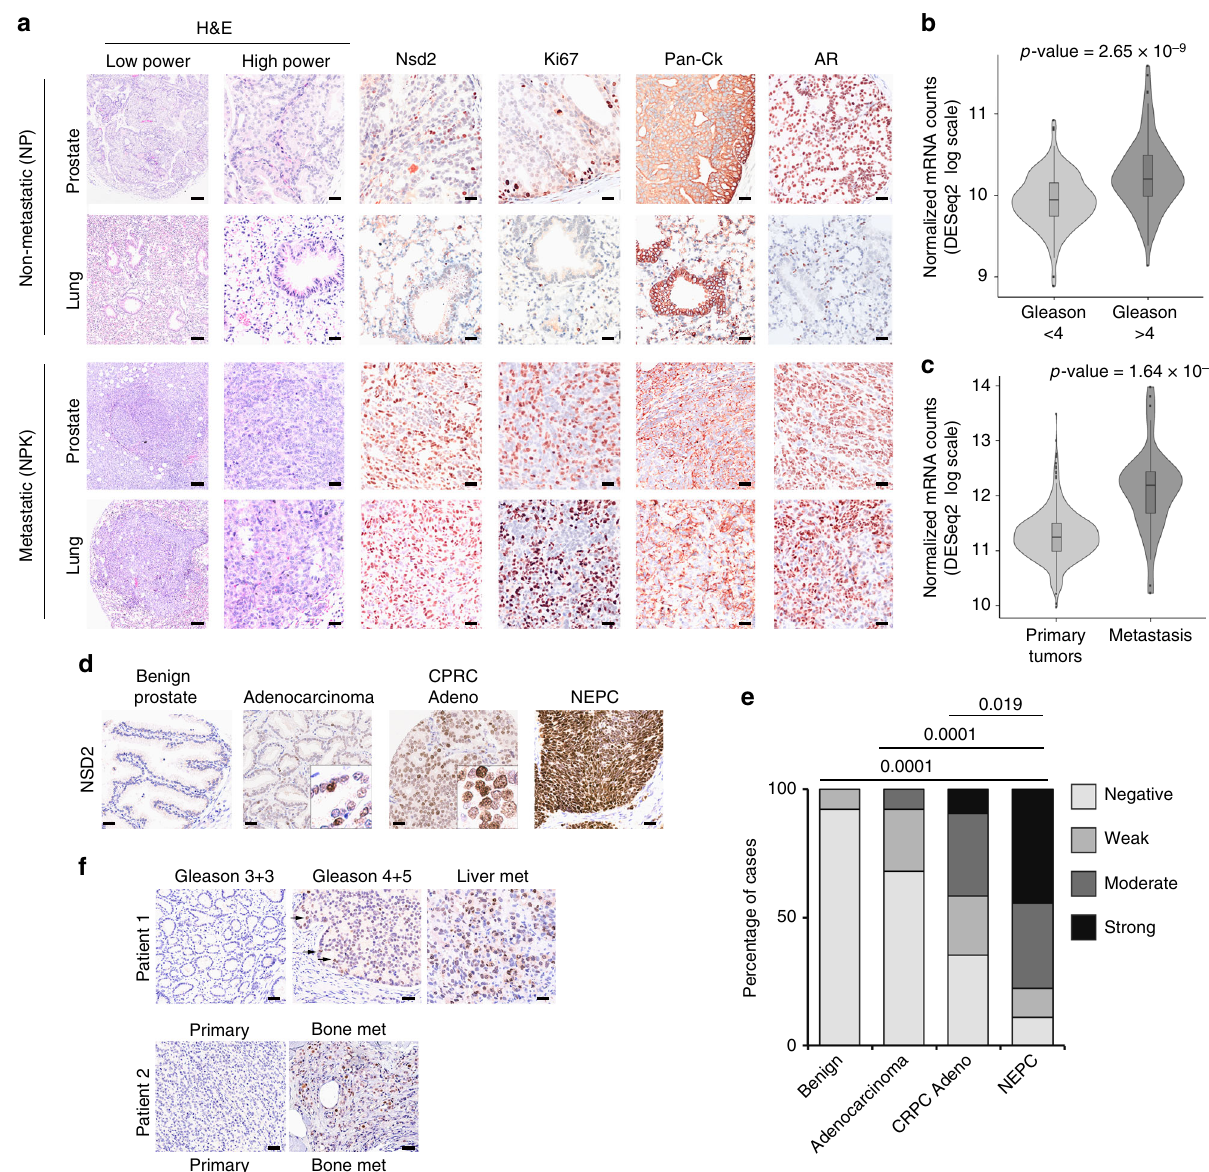
Fig. 4 Expression of NSD2 in prostate cancer and metastases. a Immunostaining of Nsd2 and other markers on mouse primary tumors and metastases. Shown are representative H&E images and immunostaining for the indicated antibodies from non-metastatic NP mice and metastatic NPK mice ( n = 4/ group). Scale bars in the low power H&E images represent 100 microns, and all other panels 50 microns. b , c Violin plots comparing mRNA expression levels of NSD2 in TCGA and SU2C human prostate cancer cohorts (Supplementary Table 1). b compares primary tumors from TCGA divided based on pathological grade [Gleason <4 ( n = 104) or ≥ 4 ( n = 173)], as indicated. c compares primary tumors and metastases from a cohort combining primary tumors from TCGA (all Gleason scores; n = 333) and metastases from SU2C ( n = 51). P -values were estimated using the two-sample two-tailed Welch t - test. d , e Immunostaining of NSD2 on a human prostate tissue microarray (TMA) ( n = 100 independent cases). d shows representative images representing benign prostate, untreated localized adenocarcinoma, castration-resistant adenocarcinoma (CRPC-Adeno) and neuroendocrine prostate cancer (NEPC). Nuclear staining intensity was evaluated blinded by a pathologist and scored as negative (or present in <5% of nuclei), weak, moderate or strong. Scale bars represent 50 microns. e shows quanti fi cation of nuclear intensity staining for each score (negative, weak, moderate, and strong). The p - values compare negative/weak staining versus moderate/strong staining in each group and were calculated using a two-tailed Fisher's exact test. f Immunostaining of NSD2 on matched patient sets of primary prostate cancer and distant metastasis to soft tissues or bone, as indicated. Patient 1 shows representative images of lower pathological grade (Gleason 3 + 3), which is negative for NSD2, and higher pathological grade (Gleason 4 + 5) and a liver metastasis that have increasing expression of NSD2. Patient 2 shows a high grade primary tumor (primary) that is negative for NSD2 and a matched bone metastasis in which NSD2 staining is readily detected. Scale bars represent 50 n = 31), and neuroendocrine prostate tumors (NEPC; n = 18) robust in the most aggressive phenotypes, namely CRPC (Fig. 4d). While NSD2 was either not expressed or expressed at adenocarcinomas and NEPC ( p < 0.01, two-tailed Fisher's exact low levels in the non-lethal tumors, its expression increased test; Fig. 4e). To further evaluate the relationship of NSD2 dramatically in advanced disease stages and was particularly expression with progression to lethal prostate cancer, we